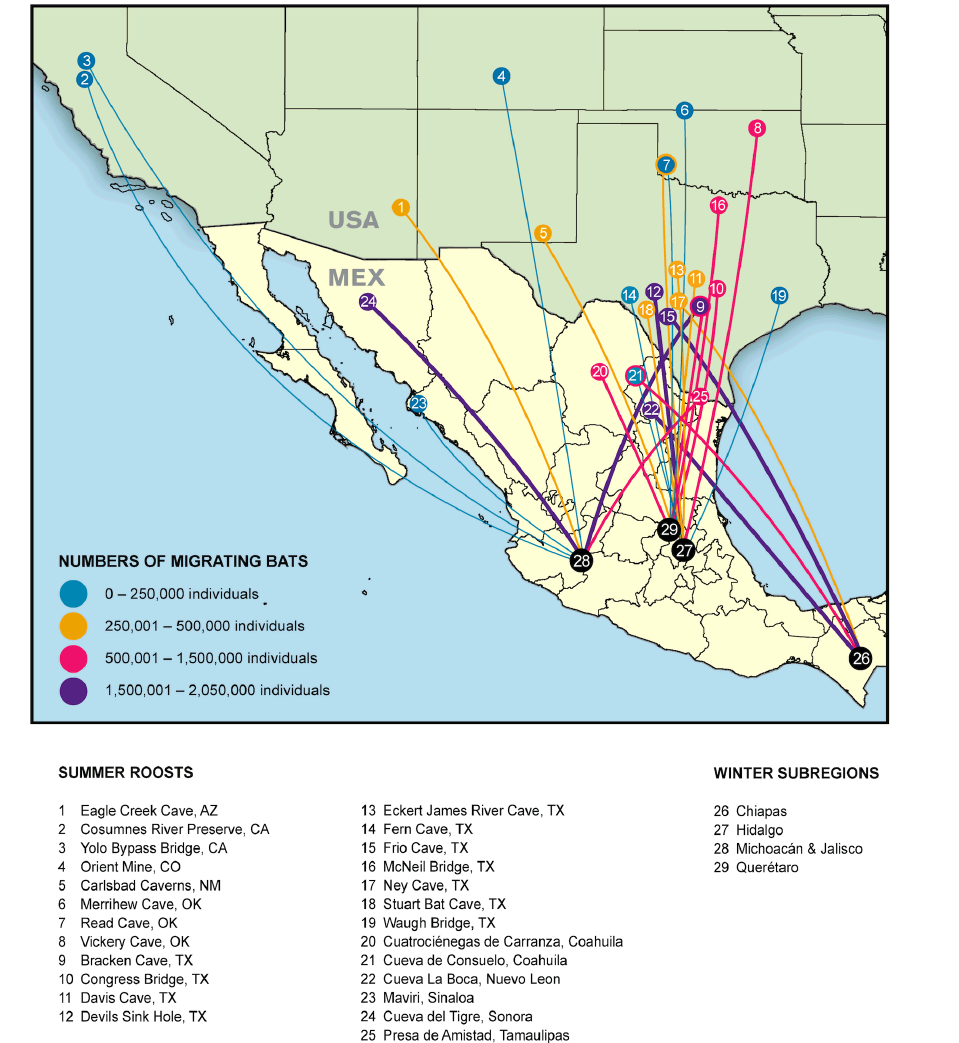
Fig. 1 . Summer breeding roost sites (dots 1–25) and wintering regions (dots 26–29) for the Mexican free-tailed bat ( Tadarida brasiliensis mexicana ). Line colors represent the total number of migrant bats. If a summer site was connected to more than one route, the circle representing the summer site was filled and outlined with the colors of the two different routes (from Wiederholt et al.